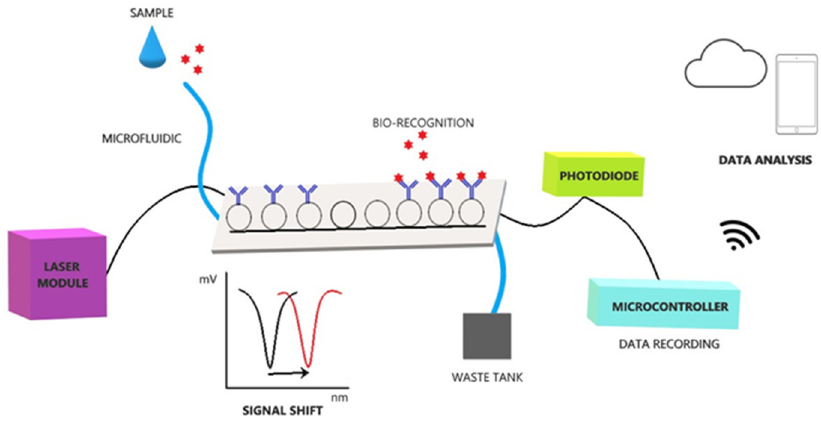
Figure 1. The novel POC system concept.